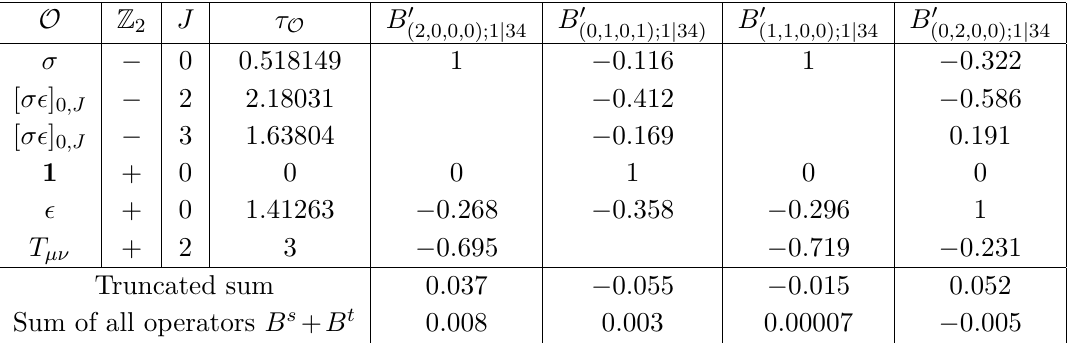
. O i O j O f O l O k O